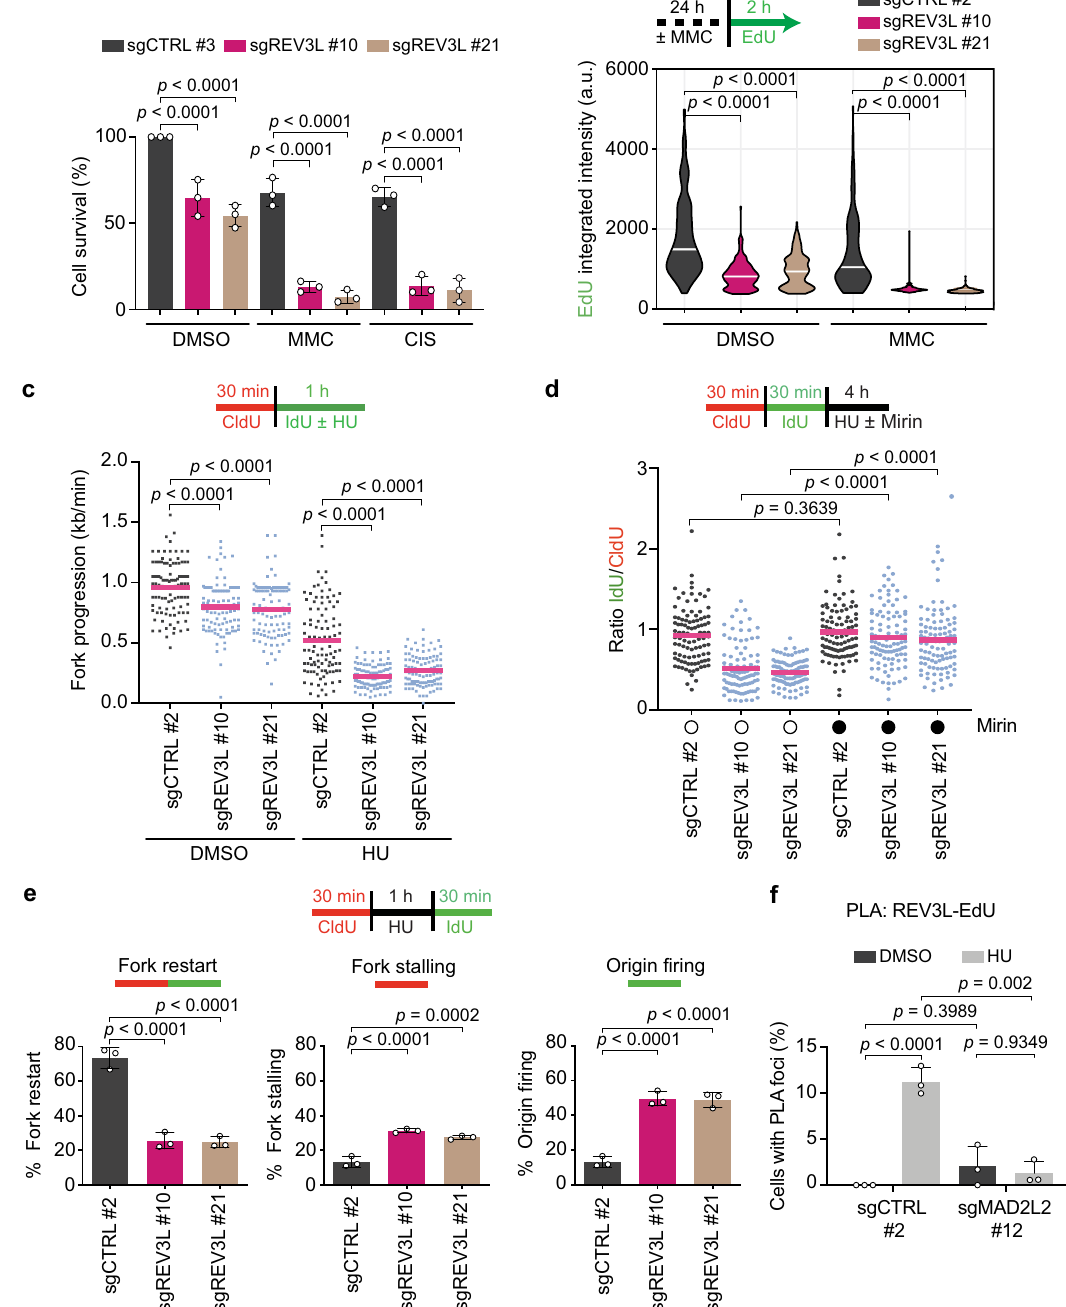
e Schematic and quanti fi cation of fork restart, fork stalling, and origin fi ring in control and REV3L-depleted HeLa cells treated with 4mM HU for 1h as indicated. Data are represented as mean±SD. Each dot represents one of three independent the Supplementary Information. Statisticalanalysis in( f )was performed according to two-way ANOVA with Tukey ’ s multiple comparisons